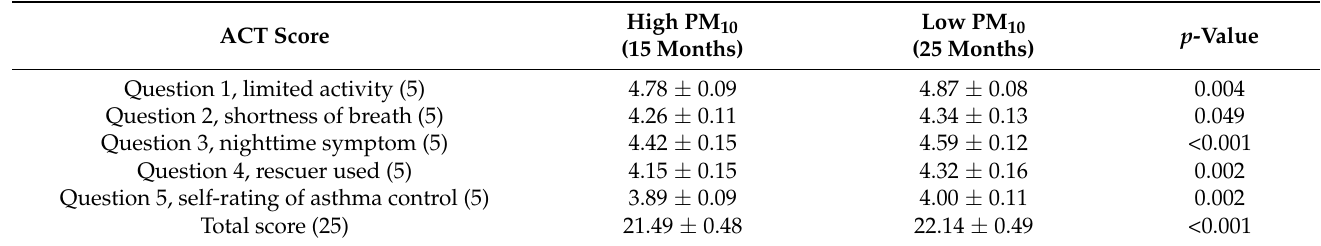
Table 4. Monthly Average of Asthma Control Test (ACT) Score in High PM 10 Periods ( ≥ 45 µ g/m 3 ) and Low PM 10 Periods (<45 µ g/m 3 ).